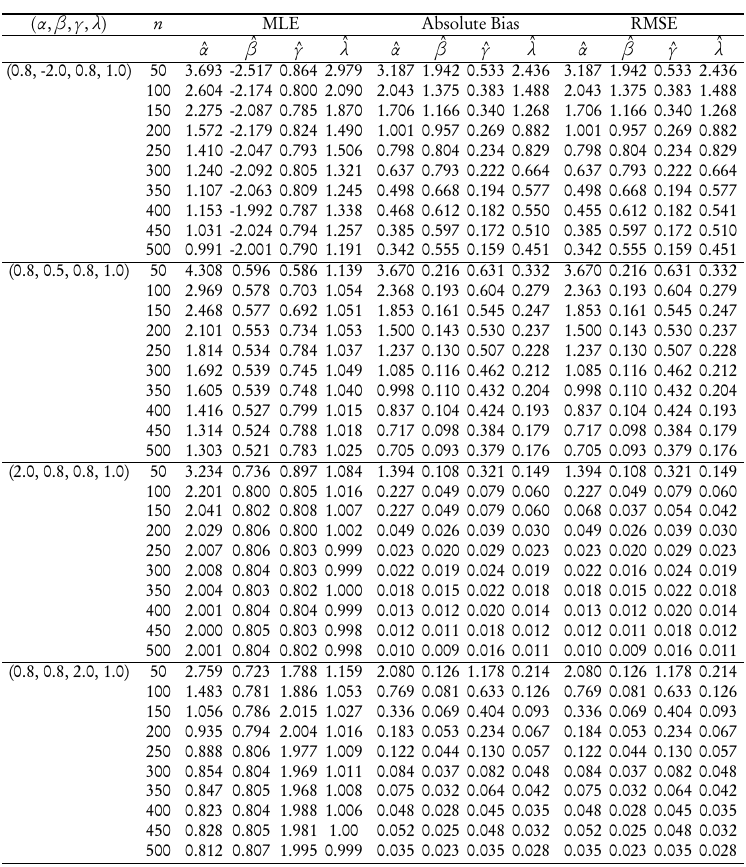
The MLEs, Std and RMSE for models